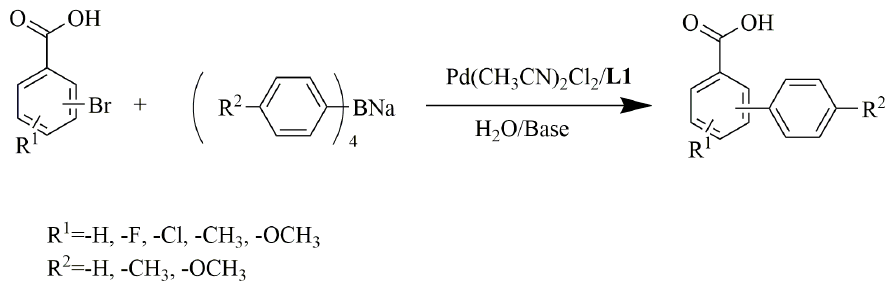
Figure 2. Suzuki-Miyaura cross-coupling reaction catalyzed by Pd(CH 3 CN) 2 Cl 2 /L1.